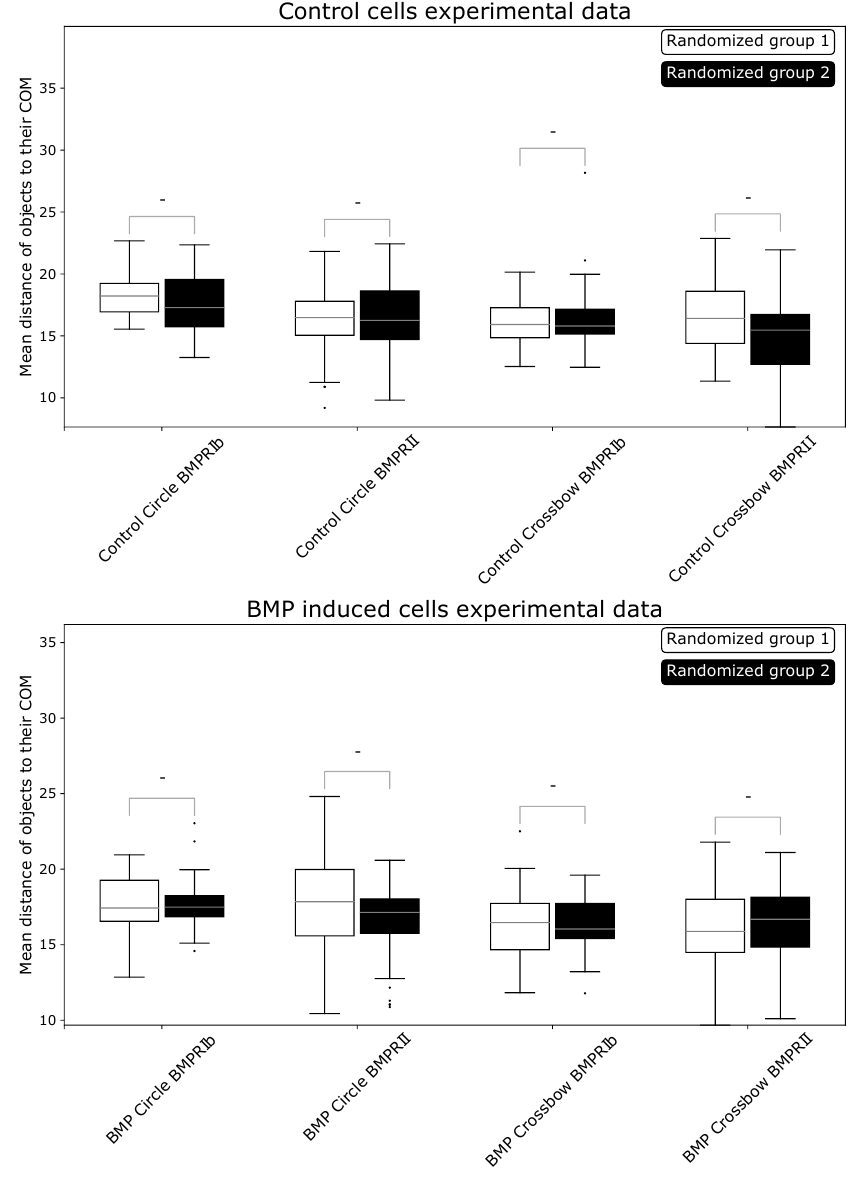
Figure A3. Comparison of experimental data randomly split into two groups for shift metric. Then, ComRed was used to assess differences in distributions. No significant differences were found. - = not